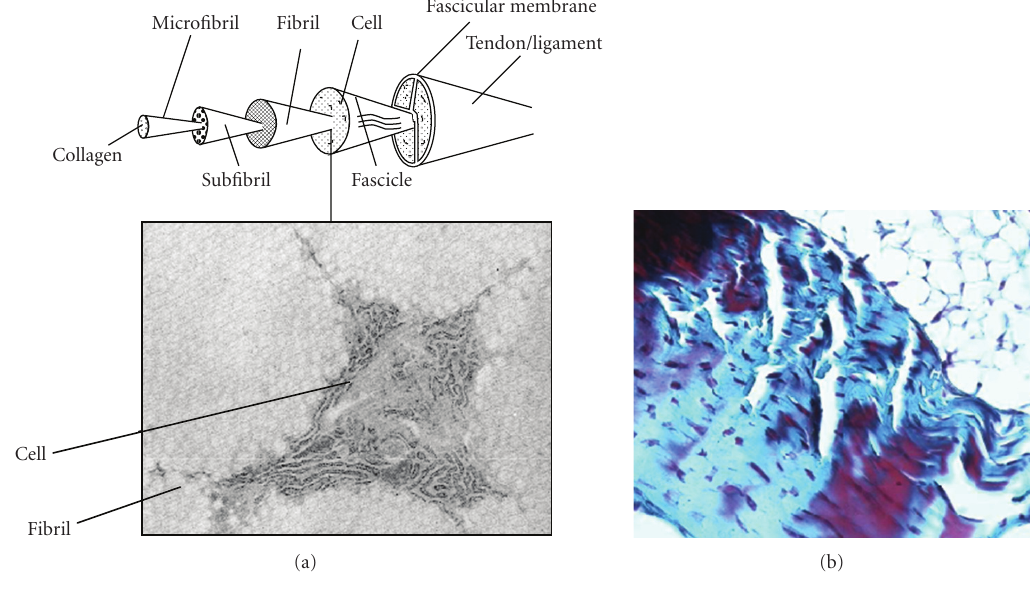
Figure 3: (a) A schematic representation of tendon hierarchical structure and a transmission electron microscopy image of a tenocyte embedded in the collagen matrix. (b) A histological (Gomori trichrome, staining collagenous tissues blue) image of a longitudinal section of patellar tendon showing parallel running collagen bundles in the tissue.